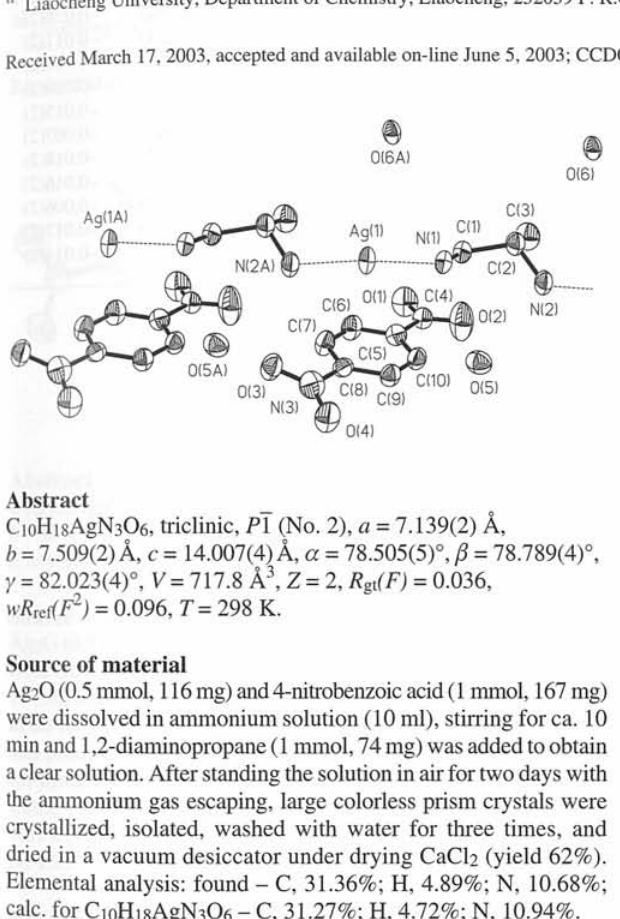
Table 2. Atomic coordinates and displacement parameters (in